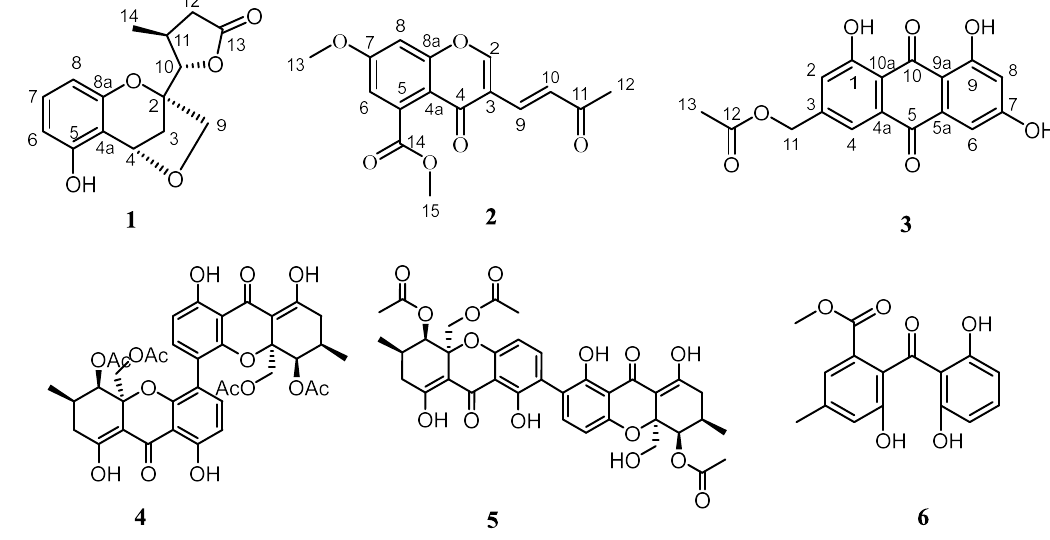
Figure 1. Chemical structures of compounds 1 – 6.